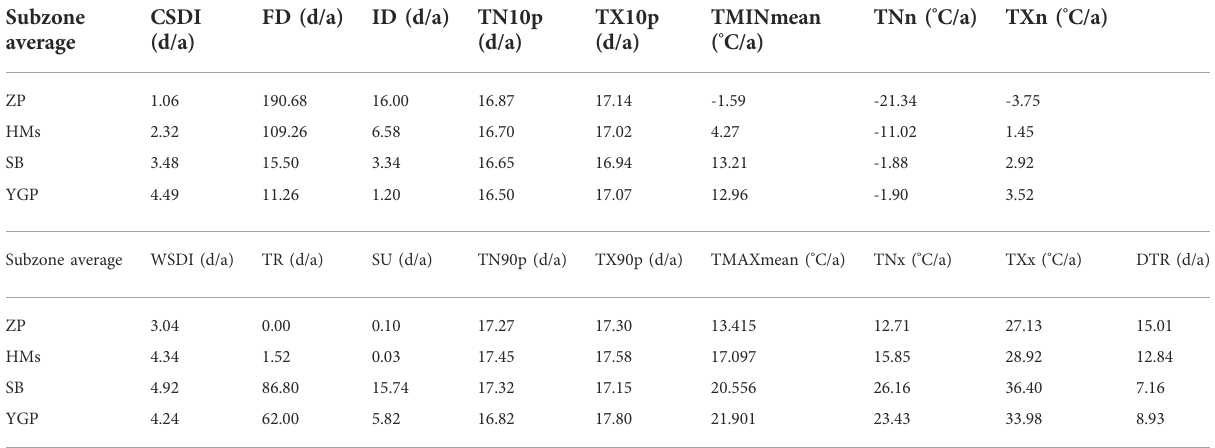
TABLE 3 Average values of 17 ETIs in different subzones from 1969 to 2020. Subzone